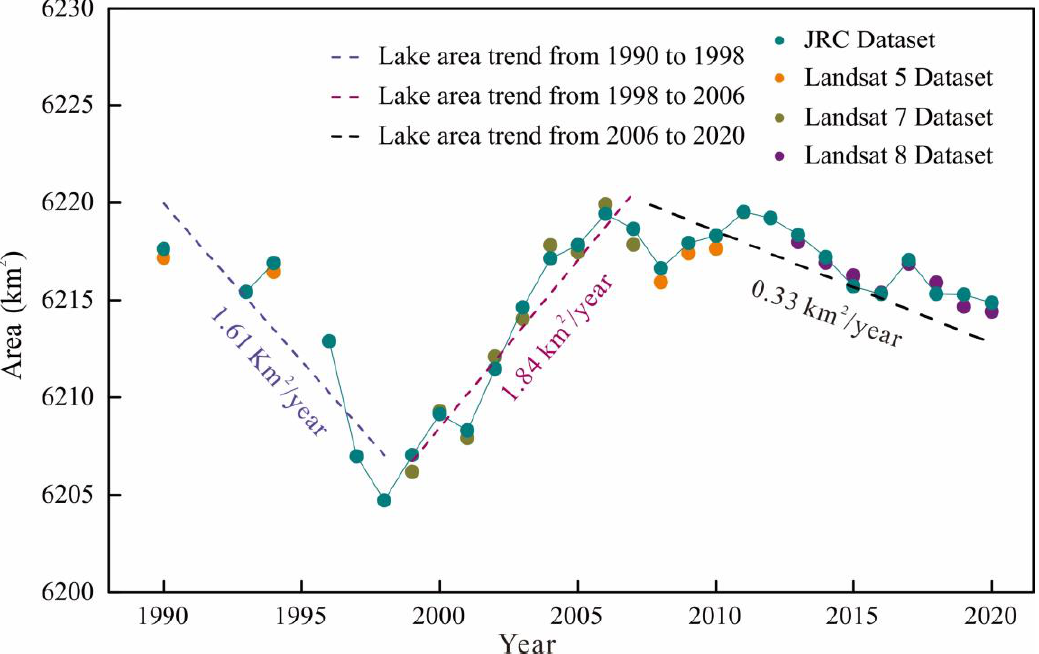
Figure 7. Inter-annual variations in the area of Lake Issyk-Kul from 1990 to 2020.